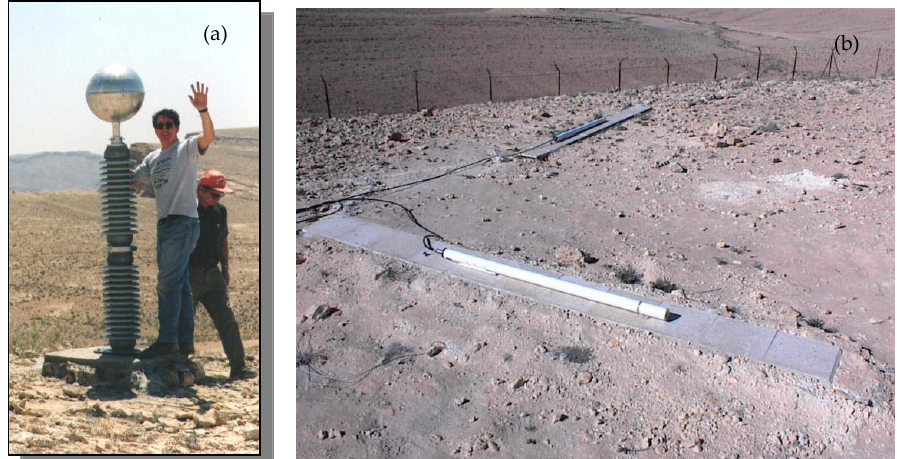
Figure 3. ( a ) Vertical electric field ball antenna with author; and ( b ) two horizontal induction coils at the Mitzpe Ramon, Israel SR site.